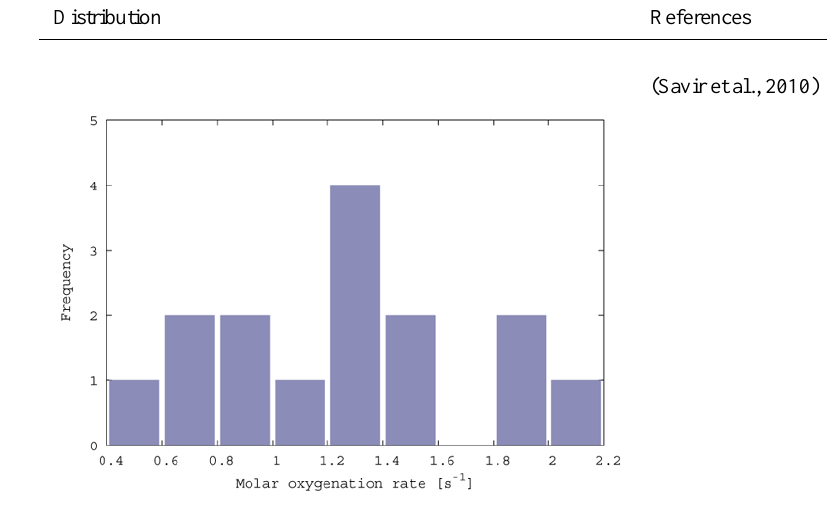
Fig. B5. Overview of the distribution of the molar oxygenation rate of Rubisco. Distribution